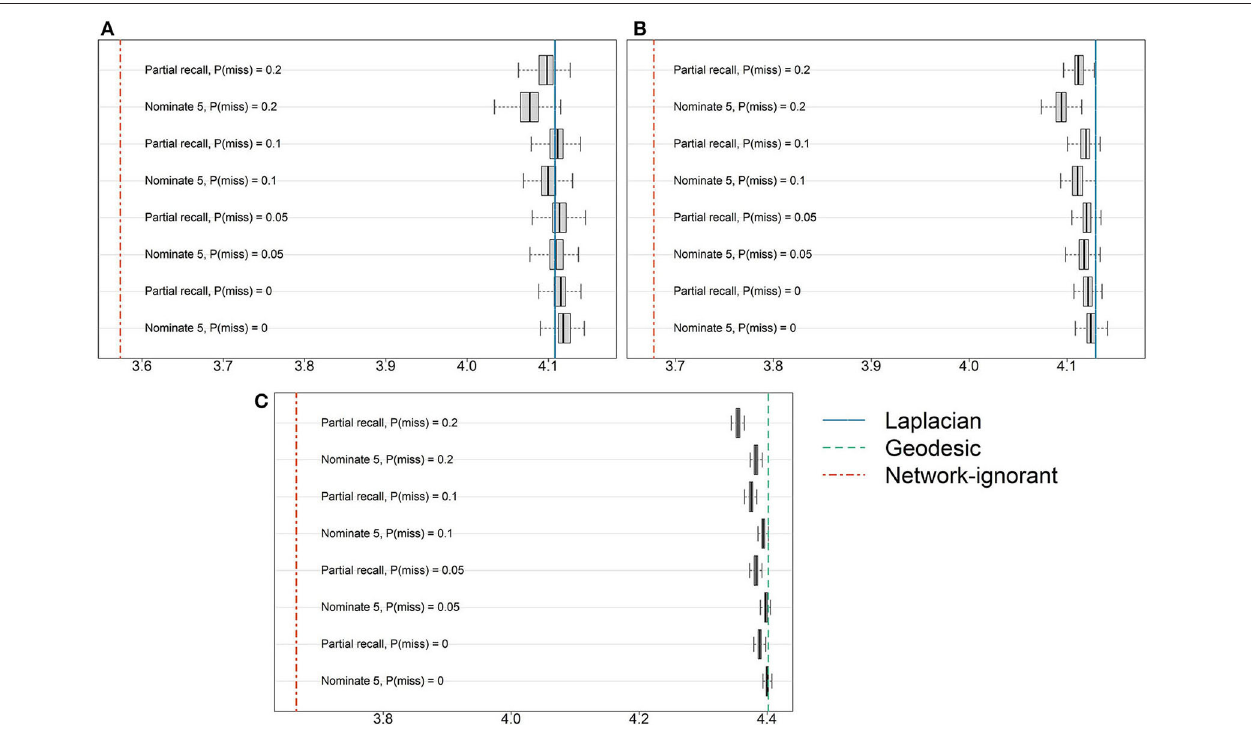
FIGURE 2 | Results from introducing missingness into the (A) AH495, (B) AH2587, or (C) ERGM10000 network by simulating two common network survey tools and varying the level of non-response. The horizontal axis corresponds to Q ( Z ), and vertical lines show either the average of 50 random pool assignments or results based on the true underlying